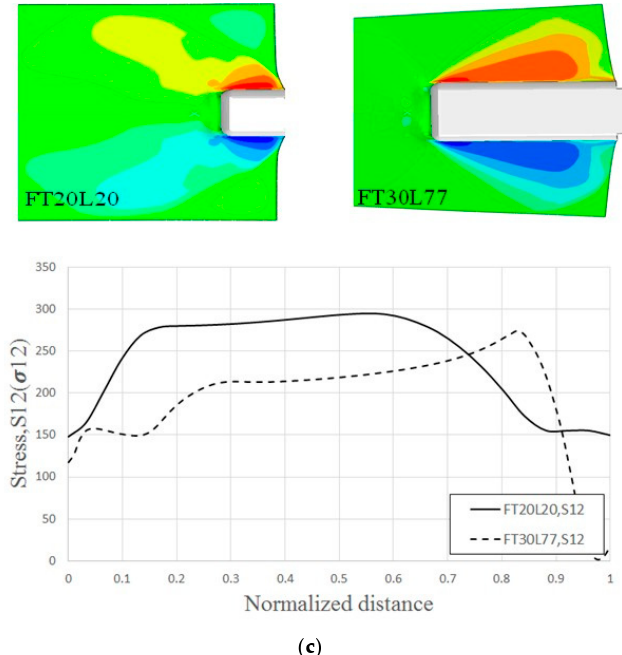
Figure 8. Stress distribution for FT20L20 and FT30L77 in Paths 3 and 4: ( a ) Definition and symbol of the Paths 3 and 4 for FT20L20, ( b ) Tensile direct stress (S22) distribution for FT20L20 and FT30L77 in Path 3, ( c ) Shear stress distribution for FT20L20 and FT30L77 in Path 4.